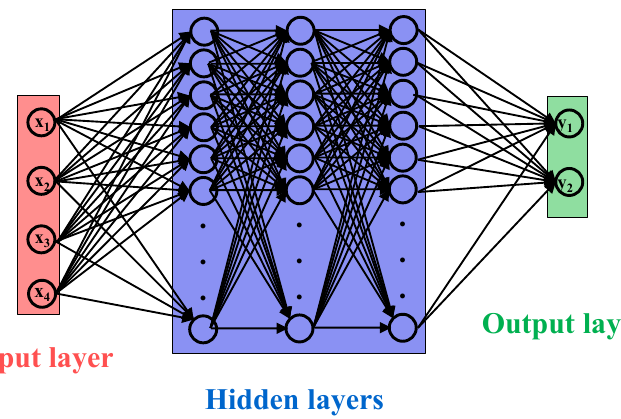
Figure 4. The architecture of an ANN model.